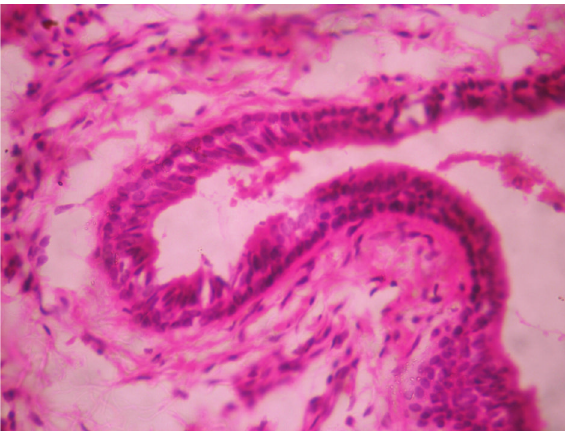
Figure 5: Dilated tortuous ducts lined by luminal columnar cells and abluminal cuboidal cells at